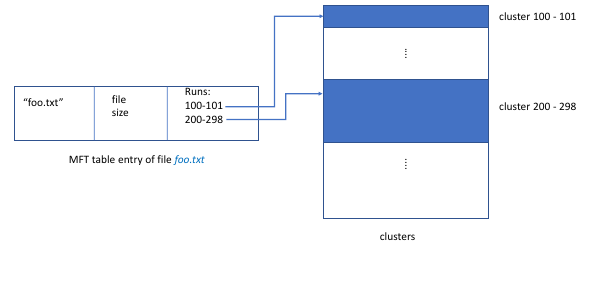
Figure 4. To illustrate NTFS file system, the MFT entry of foo.txt and the actual content carrying clusters are shown. This file has two fragments (cluster 100-101 and cluster